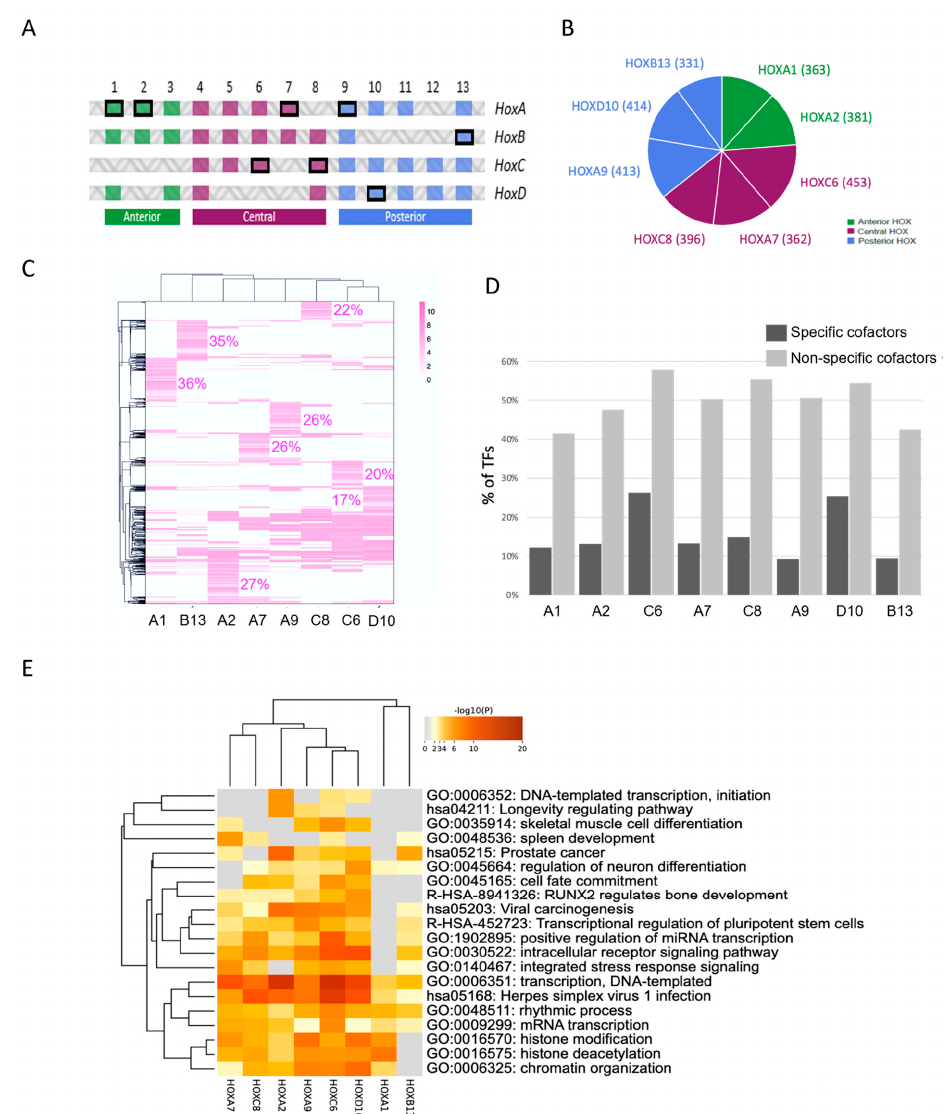
Figure 4. Application of Cell-PCA for global HOX interactome screening and comparisons. ( A ) Schematic arrangement of the 39 human HOX genes. HOX genes belonging to anterior (green), central (purple) and posterior (blue) paralog groups. The 8 HOX genes used in the screen are high- lighted (framed in black). ( B ) Pie chart illustrating the number of interacting ORFs identified for each HOX protein in the Cell-PCA screens. ( C ) Heatmap of interacting ORFs identified for each HOX protein in the Cell-PCA screens. Hierarchical clustering was performed on both columns and rows according to the Pearson distance based on log2-fold change (FC) values using average method. The proportion of HOX-specific interactions is indicated (as a % of total interactions of each HOX protein). Scale bar indicates enrichment score (log2FC) for each HOX-interacting ORF. The proportion of HOX-specific interactions is indicated. ( D ) Distribution of DNA-binding-domain-containing tran- scription factors (TFs) of HOX-specific (dark gray) or non-HOX-specific (light gray) interactors. Note that TFs constitute between 50% and 80% of the total interactions, but they are systematically more enriched in the non-HOX-specific category. ( E ) Heatmap of the top-20 enriched functional profiles of the different HOX-interacting proteins. Hypergeometric p-values and enrichment factors were calculated and used for filtering. A hierarchical clustering was performed on both columns and rows based on kappa statistical similarities among their gene memberships. A discrete color scale was used to represent statistical significance. Gray color indicates a lack of significance. The large majority of these functions were linked to gene regulation or cell differentiation and development as